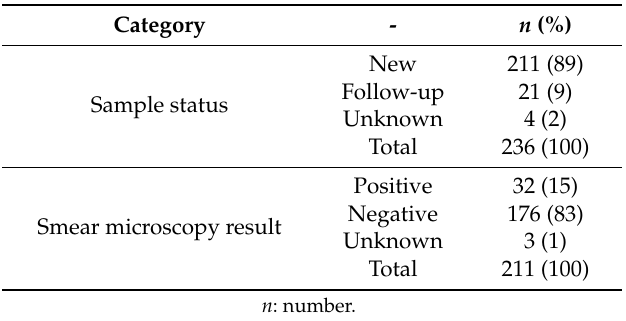
Table 3. Distribution of incoming sample status of all presumptive TB patients, and smear microscopy results for new samples